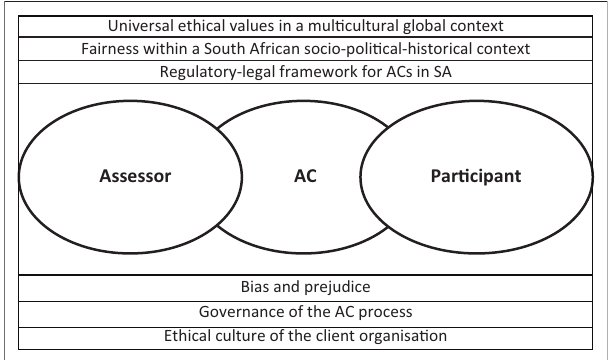
FIGURE 1: Framework for understanding ethical challenges in assessment centres